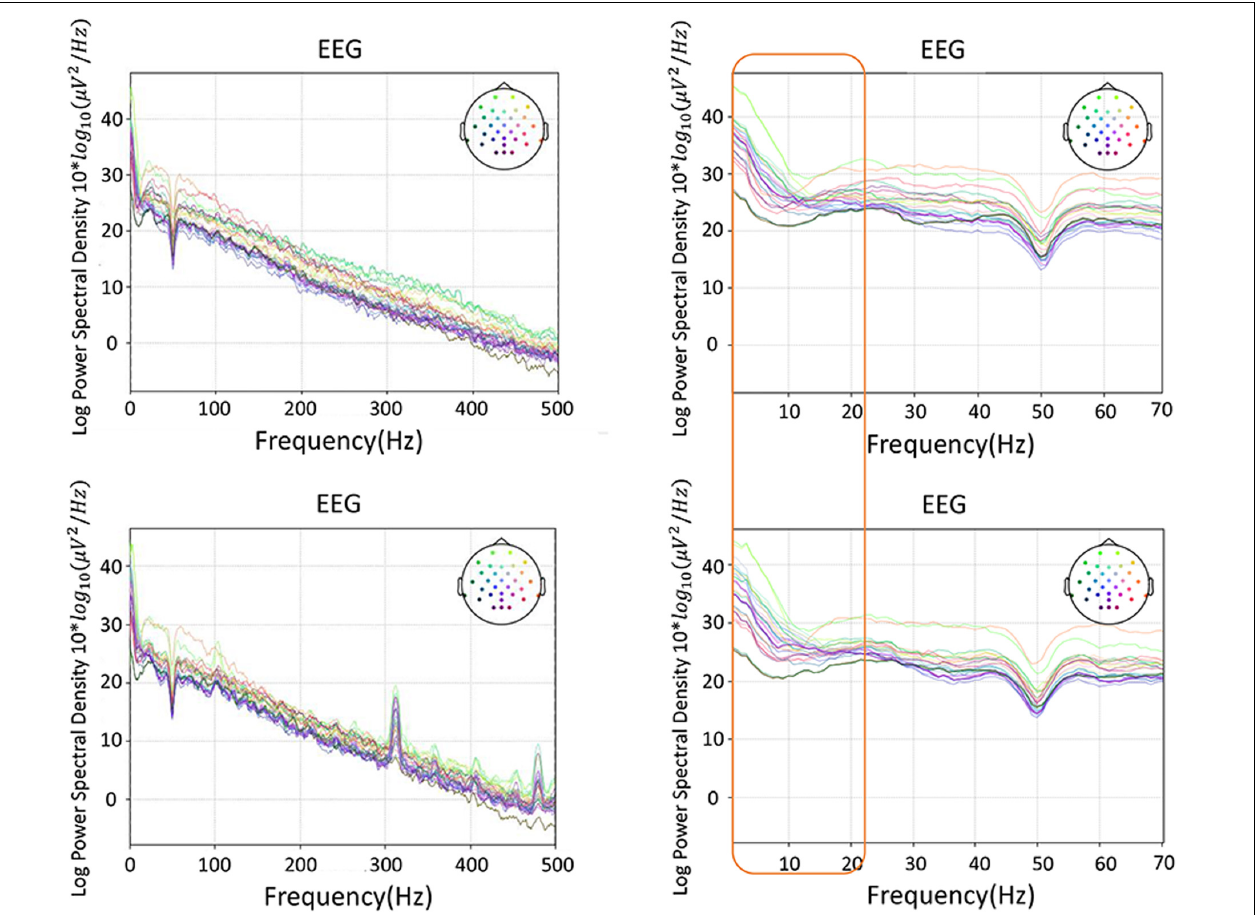
FIGURE 6 | A representative of PSD-based spectrum analysis, with the most frequency information in 20 Hz: the top row is the vibration task, the bottom row the electrical